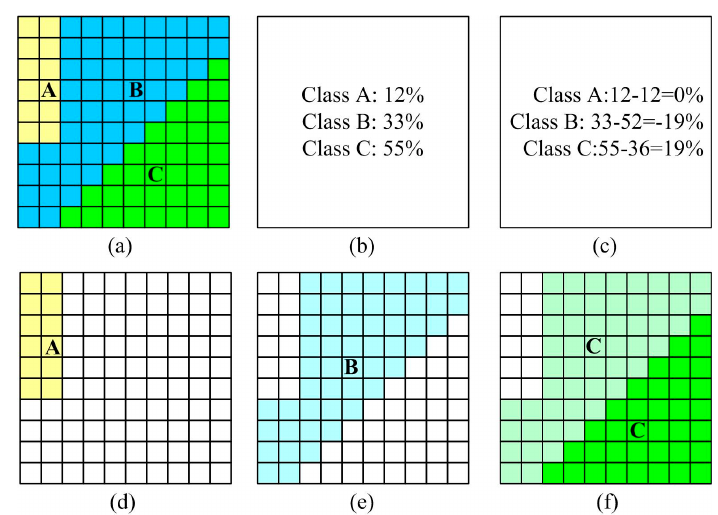
Figure 1. An example of land cover change and allocation of fine resolution pixel labels according to the change strategy: ( a ) historic 10 × 10 fine resolution pixels in a coarse resolution pixel; ( b ) corresponding current coarse resolution mixed pixel, where class fractions of each class are denoted; ( c ) fraction change of each class; ( d ) fine resolution pixel locations of class A marked in yellow color in the current fine resolution map; ( e ) potential fine resolution pixel locations of class B marked in light blue color in the current fine resolution map; and ( f ) fine resolution pixel locations of class C marked in dark green color and potential fine resolution pixel locations for the rest of class C marked in light green color in the current fine resolution map.